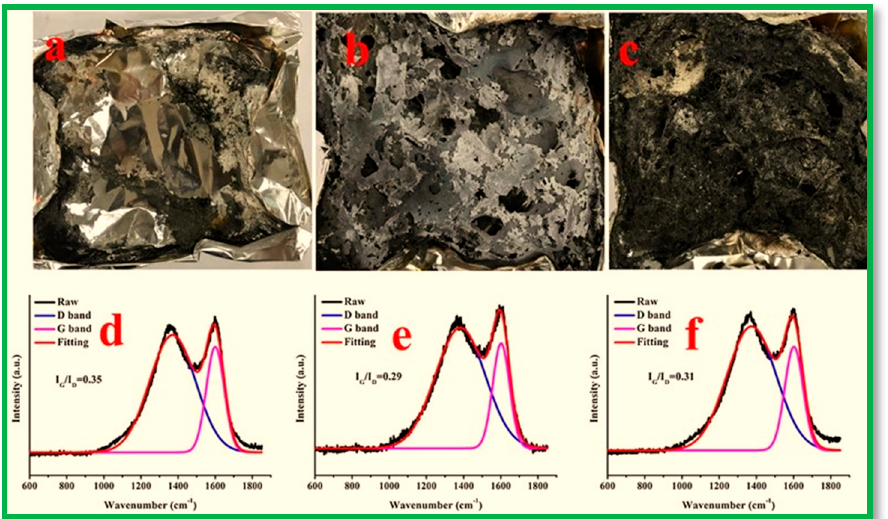
Figure 6. Photos of the chars and Raman spectra of ( a , d ) pure TPU, ( b , e ) TPU/IL – BP – 2.0, and ( c , f ) TPU/pure – BP – 2.0. Copyright 2019, Elsevier Inc. Amsterdam, The Netherlands. Reproduced with